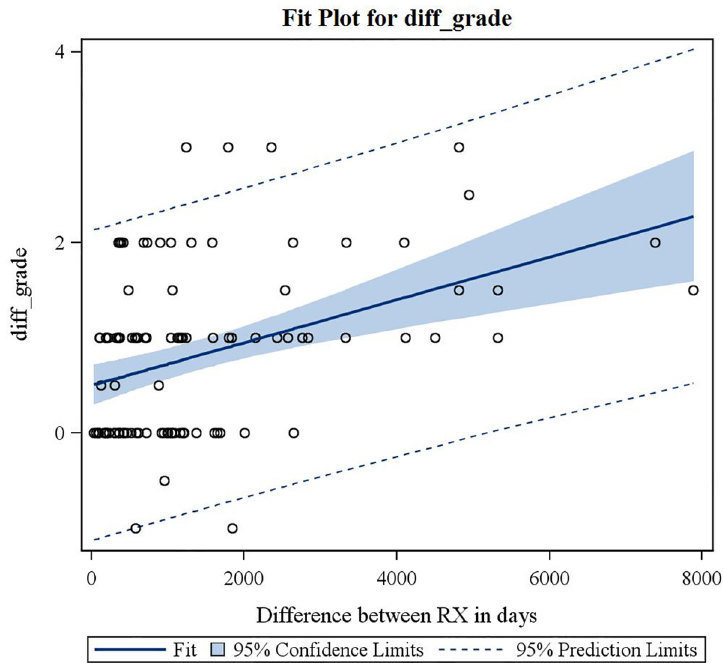
Fig 9. Fit-plot regression curve for difference in Kellgren-Lawrence grade on consecutive radiographs over